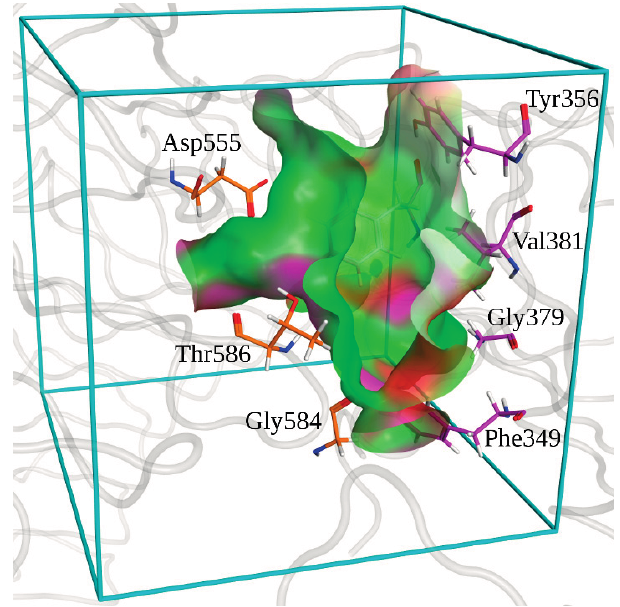
Figure 11. Surface of the binding pocket of TLR7. Hydrophobic zones are depicted in green. Polar zones are depicted in purple. Zones exposed to the solvent are depicted in